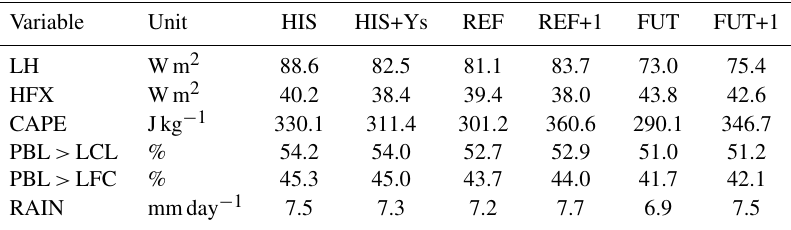
Table 2. Mean daily (00:00–00:00UTC) values of latent heat flux (LH), sensible heat (HFX), convective available potential energy (CAPE), precipitation (RAIN), and daytime (06:00–18:00UTC) values of the percentage of time and area that the planetary boundary layer top is over the level of free convection (PBL > LFC), likewise for lifting condensation level (PBL > LCL), over the Netherlands for the conducted experiments.